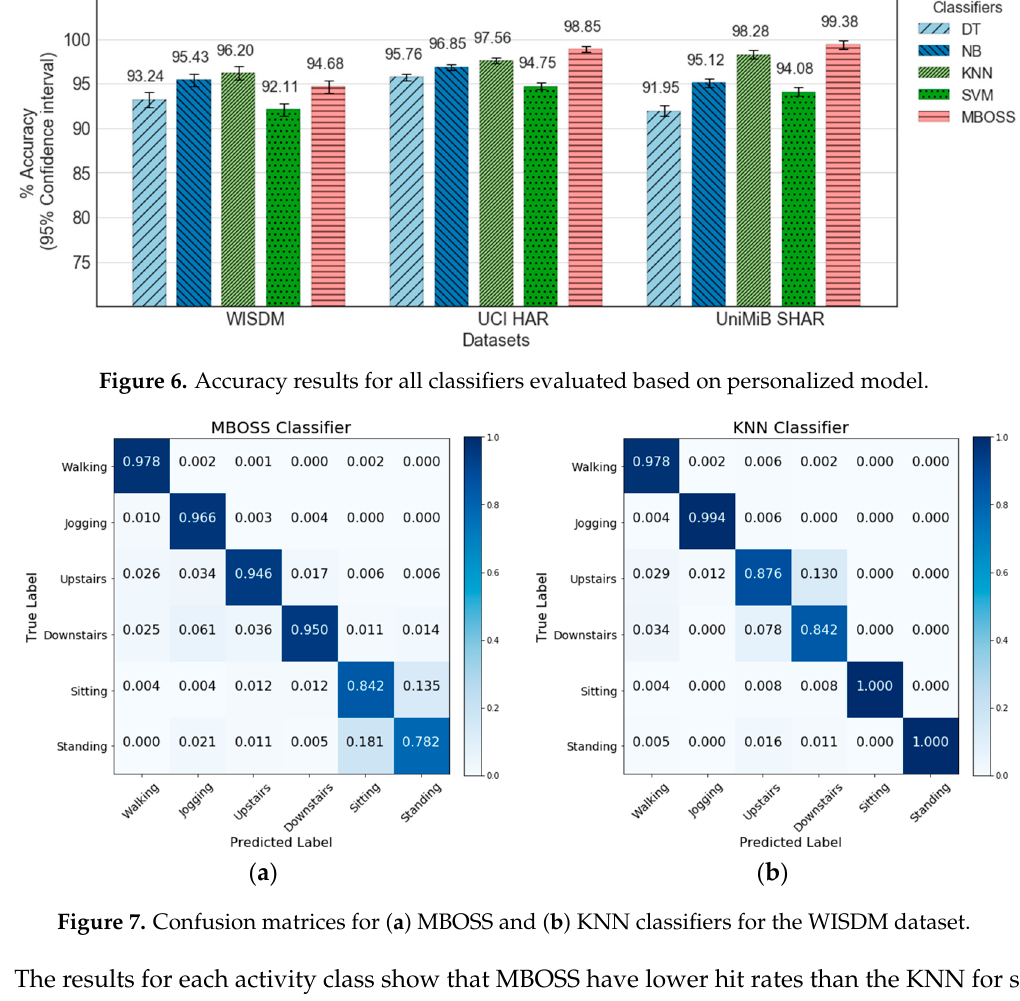
Figure 8. Accuracy results for all classifiers evaluated based on generalized model.